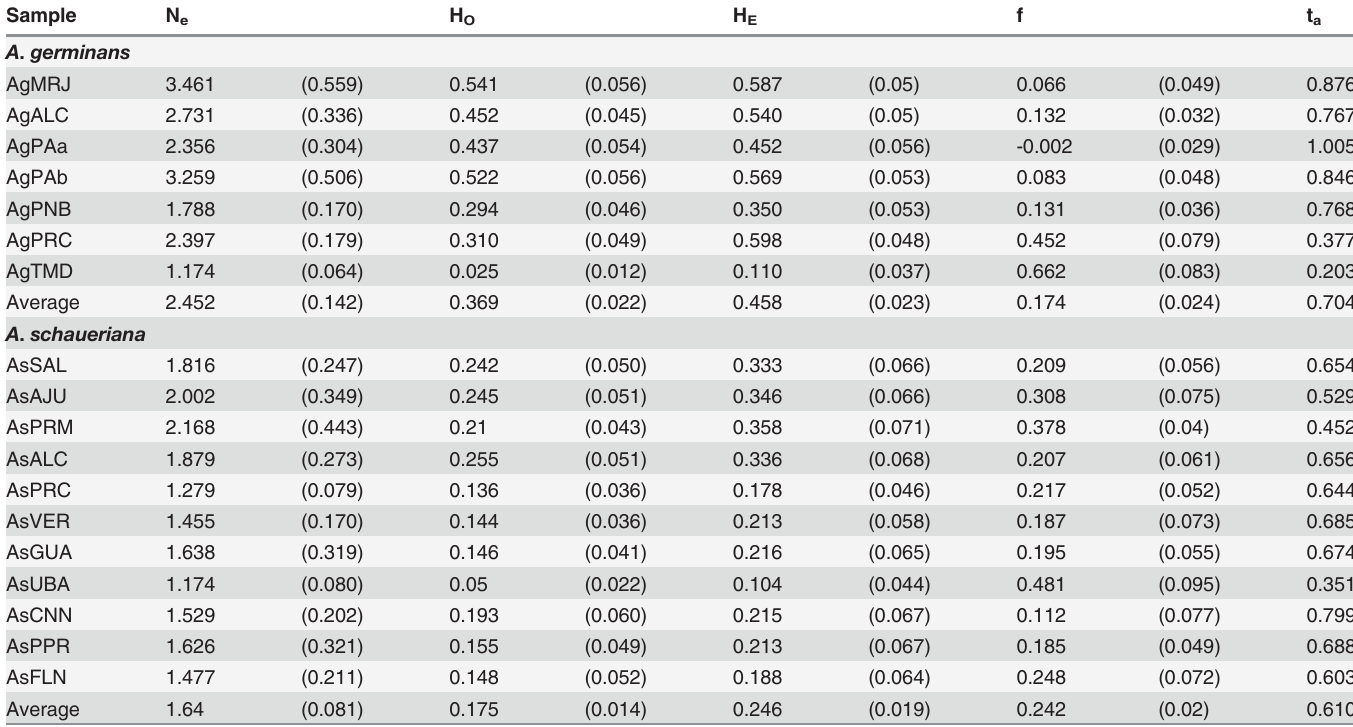
Table 3. Intraspeci fi c genetic diversity of A . germinans and A . schaueriana samples from the Brazilian coast. Sample codes are denoted as in Table